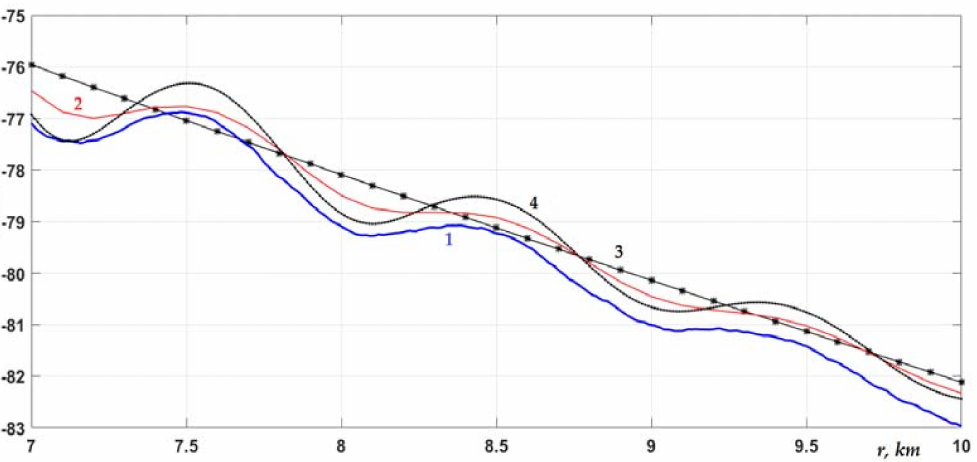
Figure 6. Similarly to Figure 5, the average intensity in the range r = 7–10 km in the waveguide. z = z 0 = 36 m. Curves: 1 is OW solution for L h = 100 m; 2 is OW solution, L h = 1 km; 3 (markers) is I in the unperturbed waveguide ( δ h = 0), averaged over the scale of interference; 4 is I in the unperturbed waveguide ( δ h =